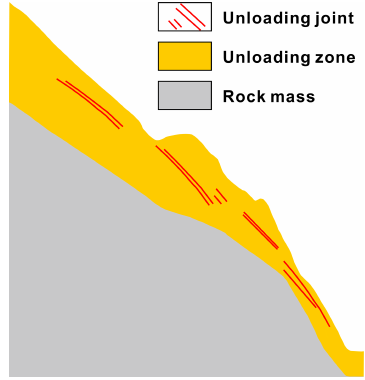
Figure 4. A schematic diagram showing shadow unloading joints in the slope.